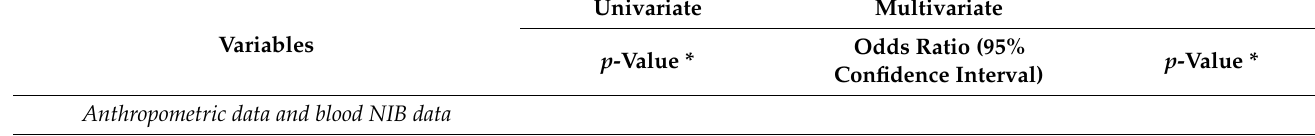
Table 1. Clinicopathological variables, biochemical and nutrition–inflammation data, anthropomet- ric and body composition characteristics, serum HLOP metabolites, and treatment-related factors of 44 patients with LAHNSCC completing the CCRT course, stratified by treatment interruption.